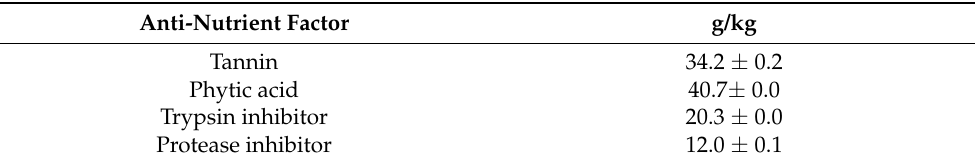
Table 3. Anti-nutritional factors content in the milled camelina meals (mean ± standard error, n = 3). Anti-Nutrient